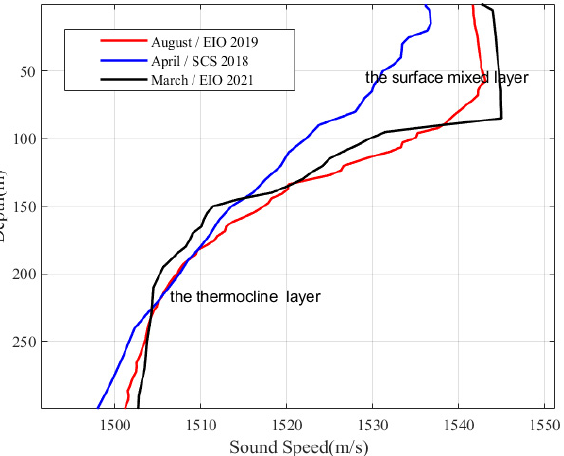
Figure 13. The detailed changes of sound speed profile in shallow surface of the EIO and SCS.